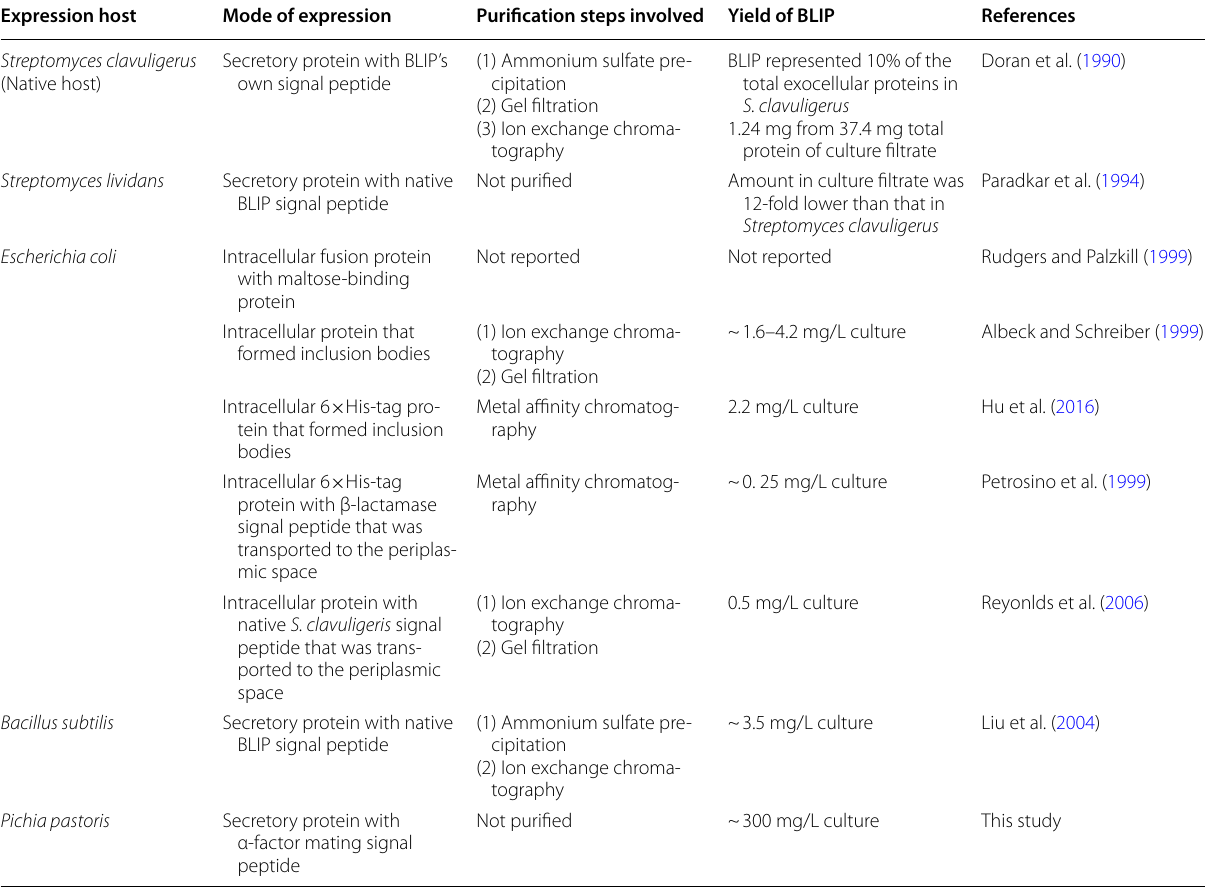
Table 1 Production of purified BLIP using various expression